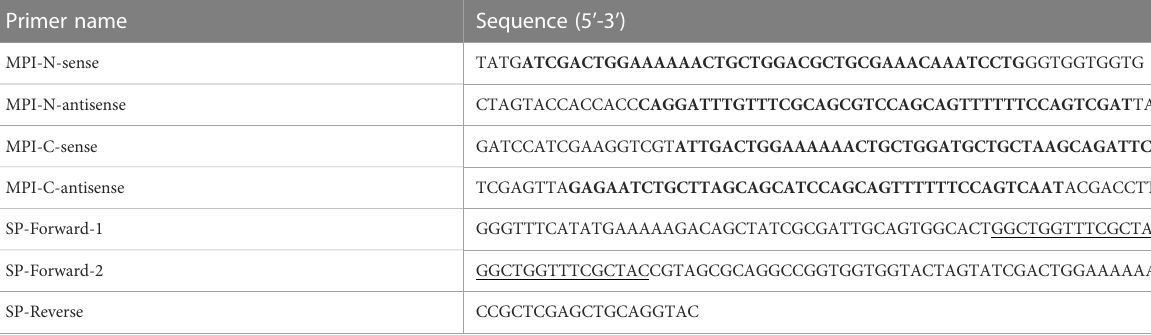
TABLE 1 Primers used to construct MPI-N, MPI-C, and MPI-SP expression